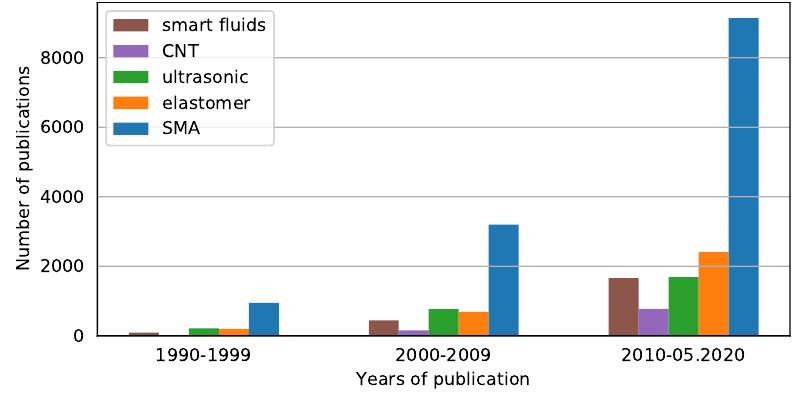
Figure 4. Publications on unconventional